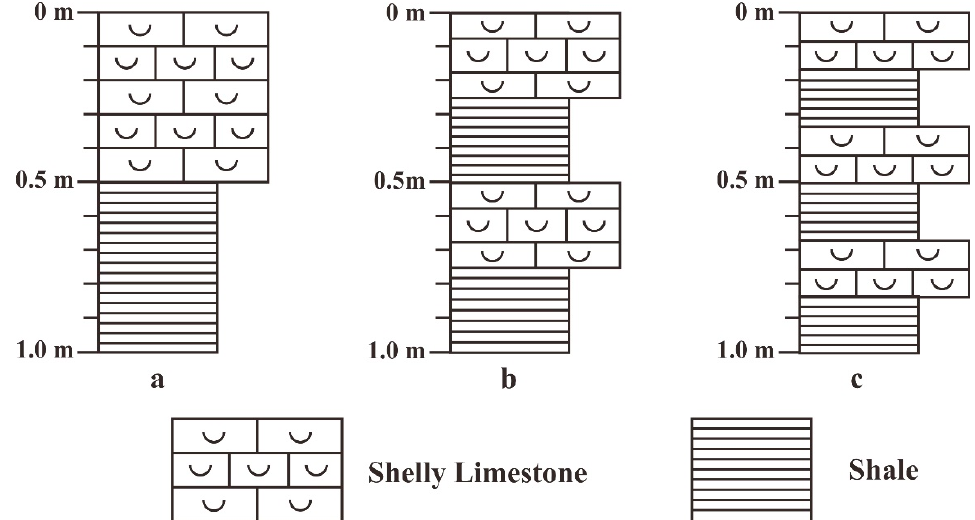
Figure 1. The same rock content leads to different lithology combinations: ( a ) single type, ( b ) multi-layer type, and ( c ) cross-bed type.